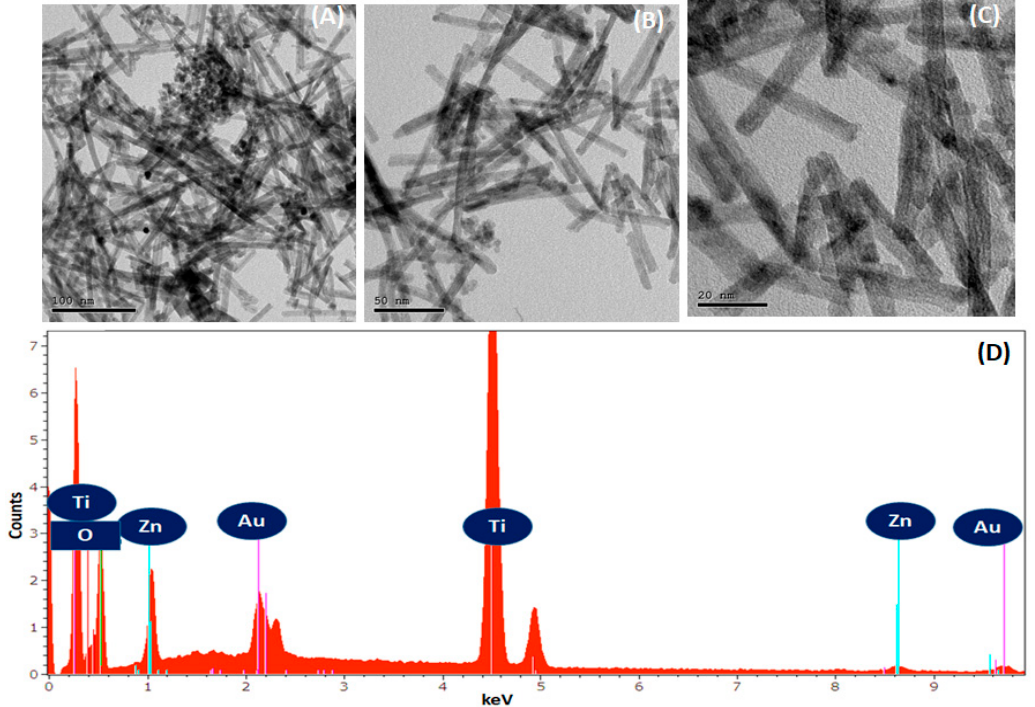
Figure 5. HRTEM with different magnification ( A – C ) and EDX analysis of Zn-doped TNTs (Zn- TNTs) ( D ). TNTs) ( D